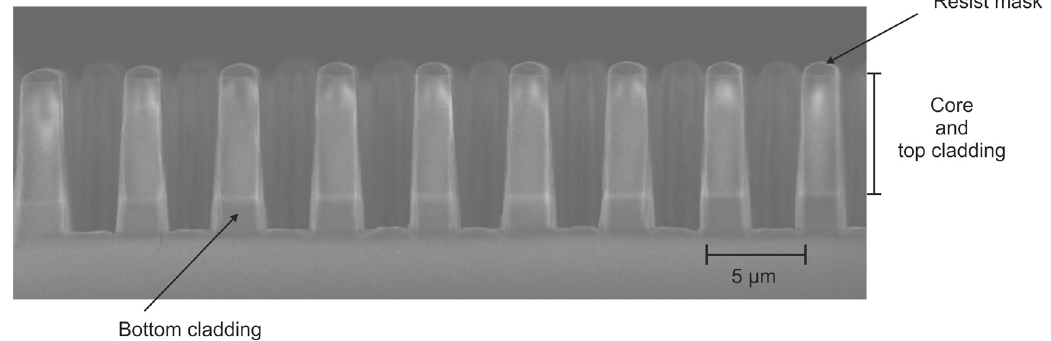
Figure 3. Scanning electron microscope image of the pillar array cross section after etching the core/top cladding and partially etching the bottom cladding, leading to a pillar height of 7.6 μm. The resist mask is still present on top of the pillars, but is partly etched